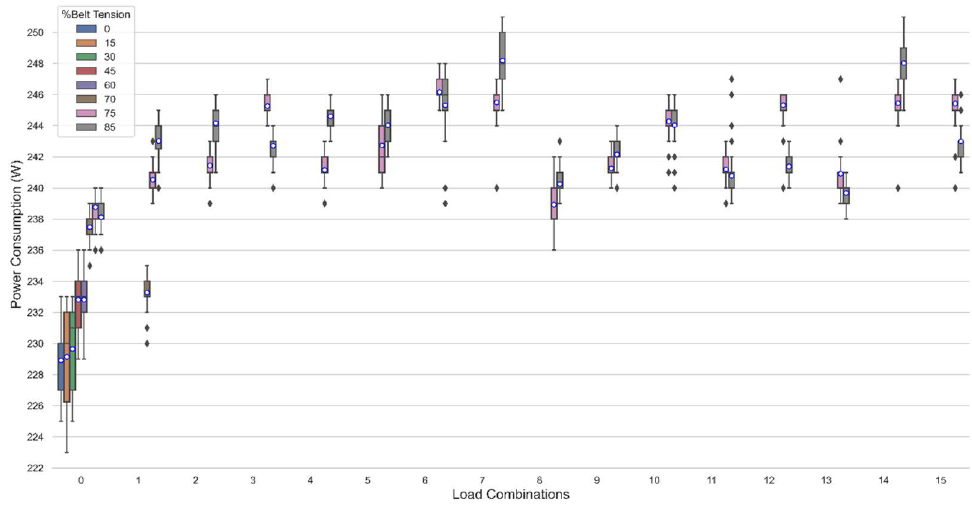
Figure 12. Comparison of 0–85% belt tensions.